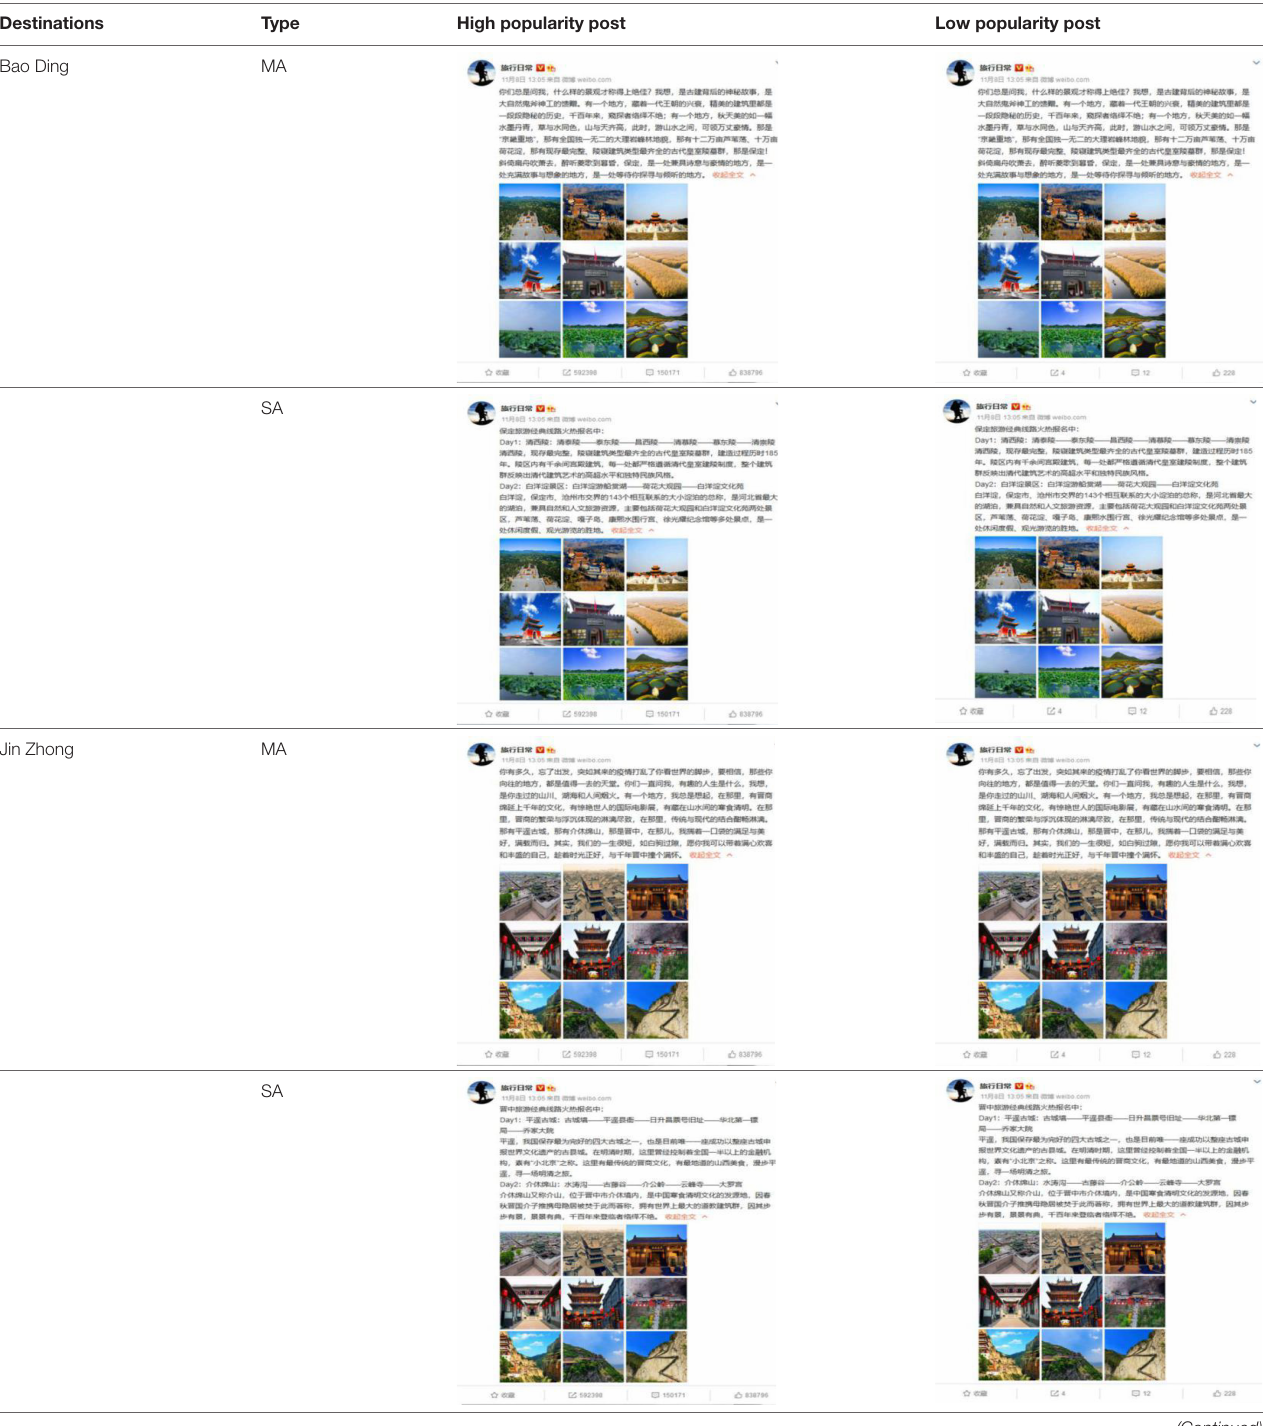
TABLE A1 | Experimental stimulus